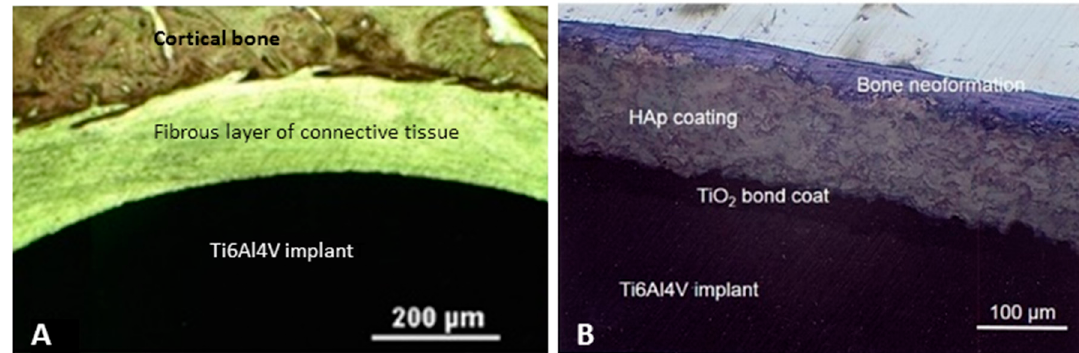
Figure 1. ( A ) Micrograph of a distal section of an uncoated Ti6Al4V rod implanted into the medulla of a sheep femur, showing the separation of the implant (black) and the bone (top) by a fibrous layer of connective tissue. ( B ) At the implant surface facing the marrow-filled femoral cavity, a thin bone lamella has formed adjacent to the continuous and intact hydroxylapatite (HAp) coating deposited by plasma spraying on a likewise plasma-sprayed TiO 2 bond coat. There is no formation of a connective tissue layer. Toluidine blue staining [20].